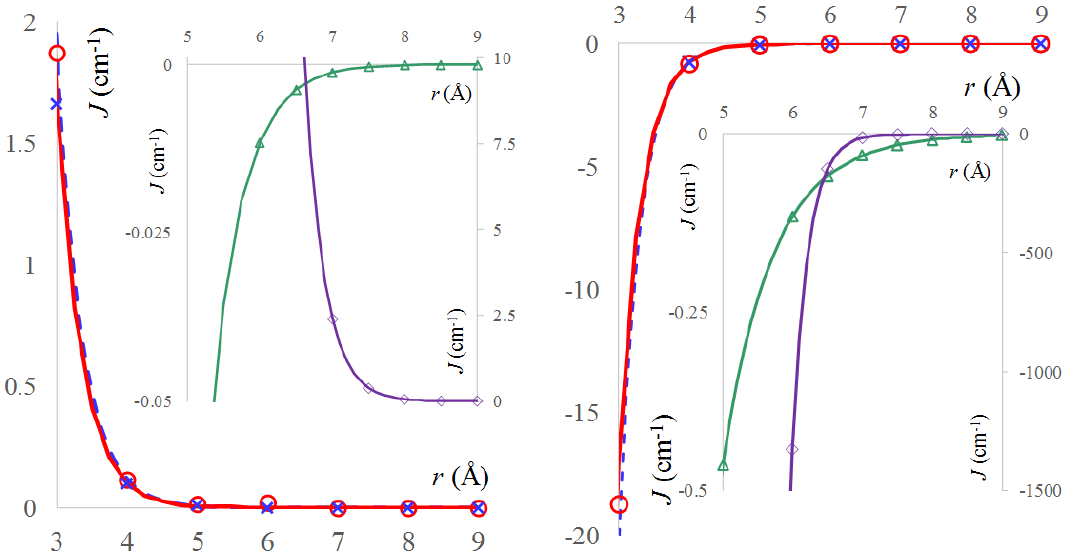
Figure 3. The computed and fitted curves for the variation of exchange coupling, J ( r ), as function of oxygen-oxygen distance ( r ) between two TEMPO radicals, taken in the Configuration 1 (left side) and Configuration 2 (right side). The circle symbols (o) correspond to computed BS-DFT data, the continuous red lines represent the fitted exponential dependences. The ( × ) symbol stands for similar data, computed with Broken-Symmetry-Density Functional Theory (BS-DFT) data and Self Consistent Reaction Field (SCRF) solvent model, while the dashed blue lines are the corresponding fit. The insets show the results of BS-DFT calculations with true solvent molecules placed at conventional orientations between radicals (See Figure 2). The diamond symbols and violet lines correspond respectively to computed and fitted data in the case of a solvent arranged with the CCl 2 moiety in the same plane with the NO ... Cl ones; the J values are represented on the right-side abscissa of each inset. The triangle symbols and green lines represent the coplanar CH 2 and NO...H moieties; the representation refers to the left-side abscissas of the